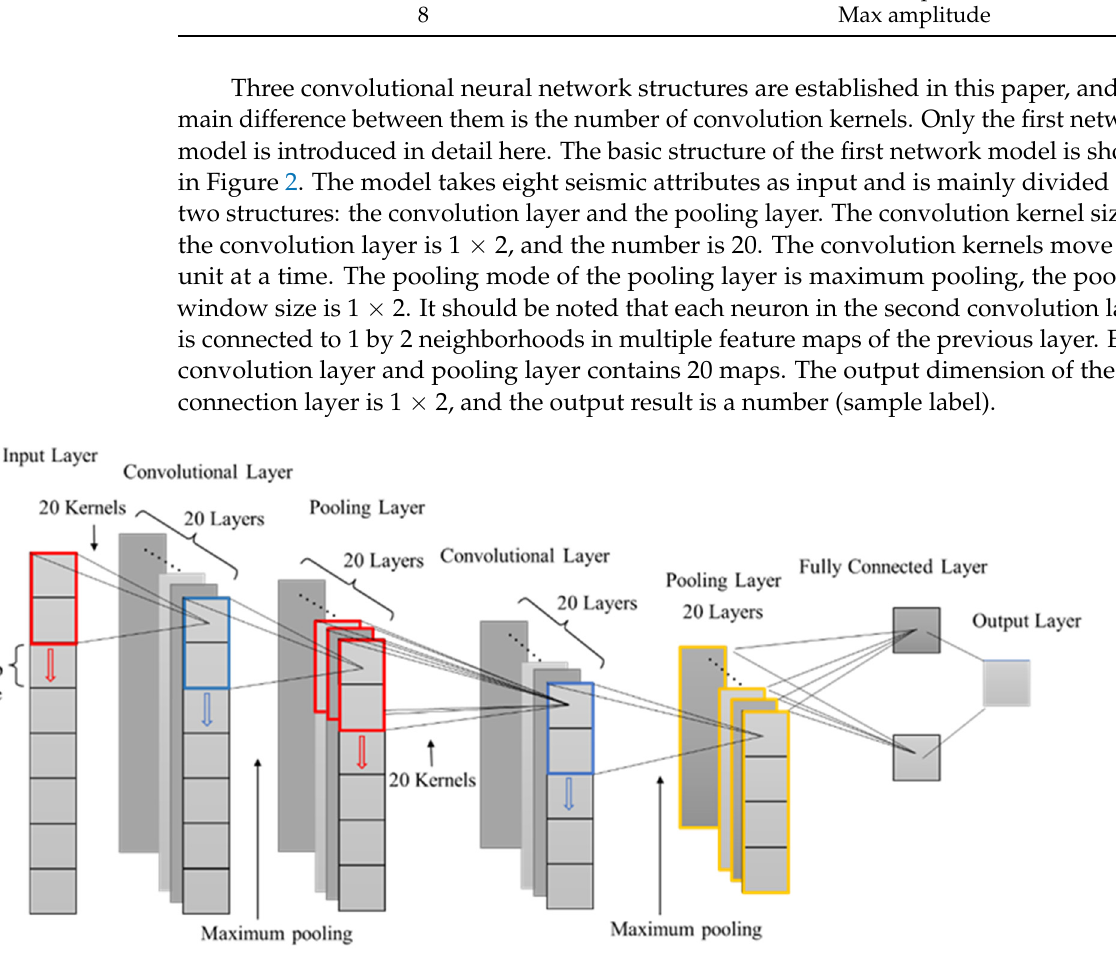
Figure 2. Basic structure of the first CNN model.